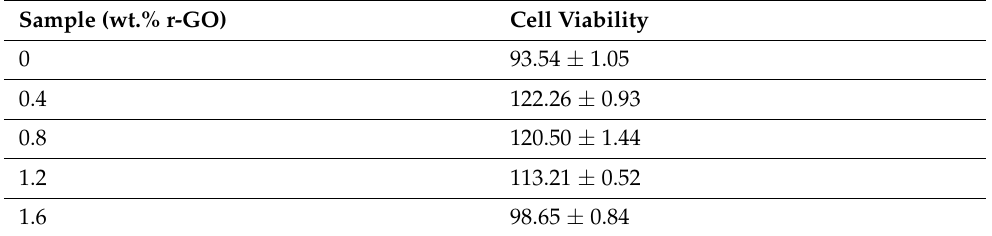
Table 4. Value in number of Cell Viability vs. Content of r-GO of Hydrogel Alginate/PVA/r-GO. Sample (wt.% r-GO)